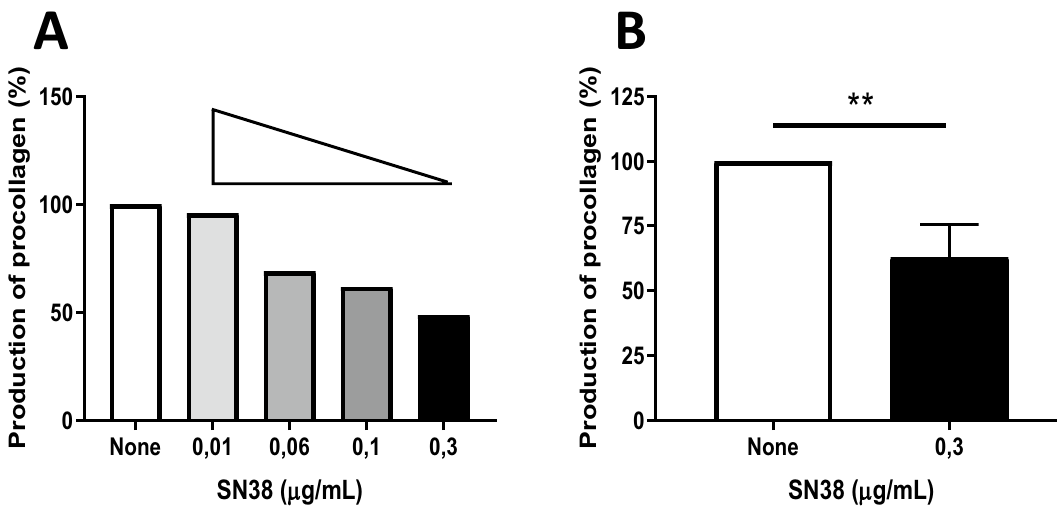
Figure 2. Analysis of SN38 effect on procollagen I release of dermal SSc fibroblasts. The level of procollagen I release was evaluated after 48 h in dermal fibroblasts from SSc patients incubated with SN38. A comparison of procollagen I release level was done between non-treated condition and treated conditions. (A) Data from a representative experiment showing a dose-dependent effect on the procollagen I production of SSc fibroblasts after incubation with 4 different doses of SN38 (i.e. 0.01 µg/ml, 0.06 µg/ml, 0.1 µg/ml, 0.3 µg/ml). (B) Cumulative data from 3 independent experiments showing a decrease of procollagen I production in SSc fibroblasts incubated with SN38 (0.3 µg/ml). ** p < 0.01 using paired